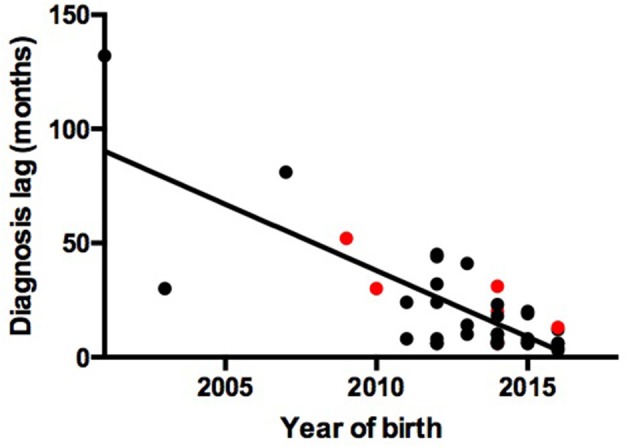
Association between year of birth and diagnosis lag. Red points represent patients with gene mutations. Black points represent patients without gene mutations.